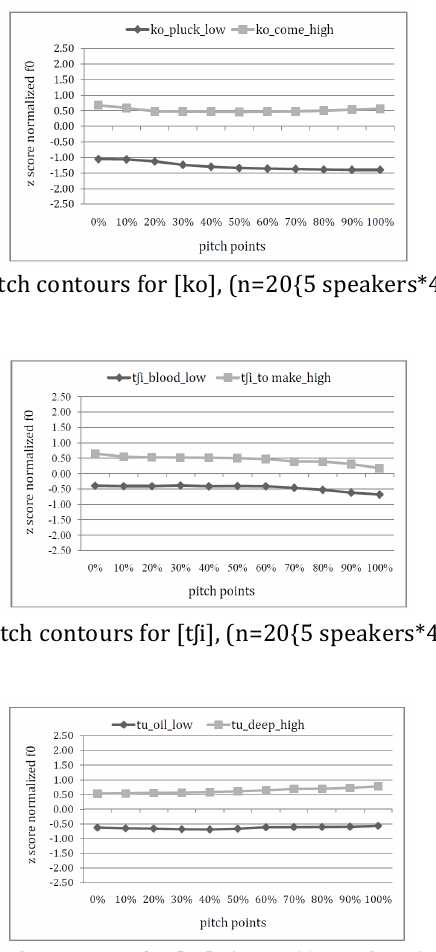
Figure 8: Normalized pitch contours for [tu], (n=20{5 speakers*4 iterations